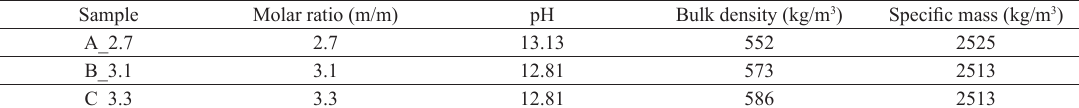
/Al O molar ratio. 2 2 3